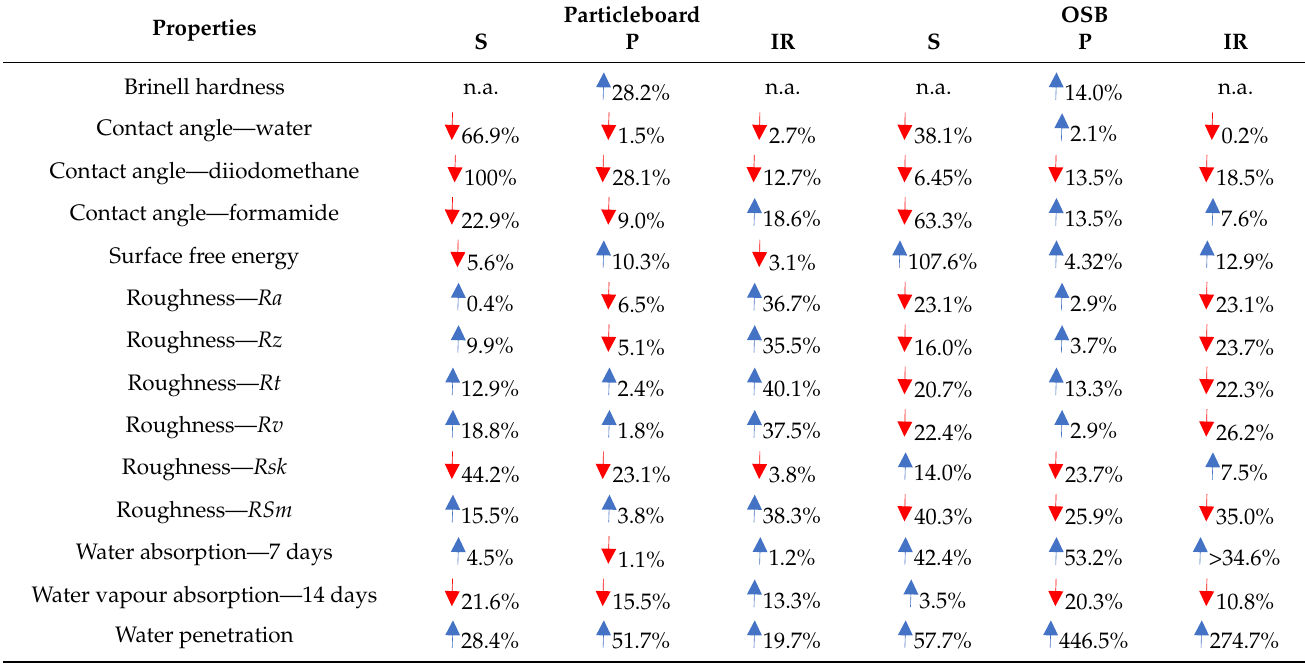
Increase in value compared to raw panel. Decrease in value compared to raw panel.